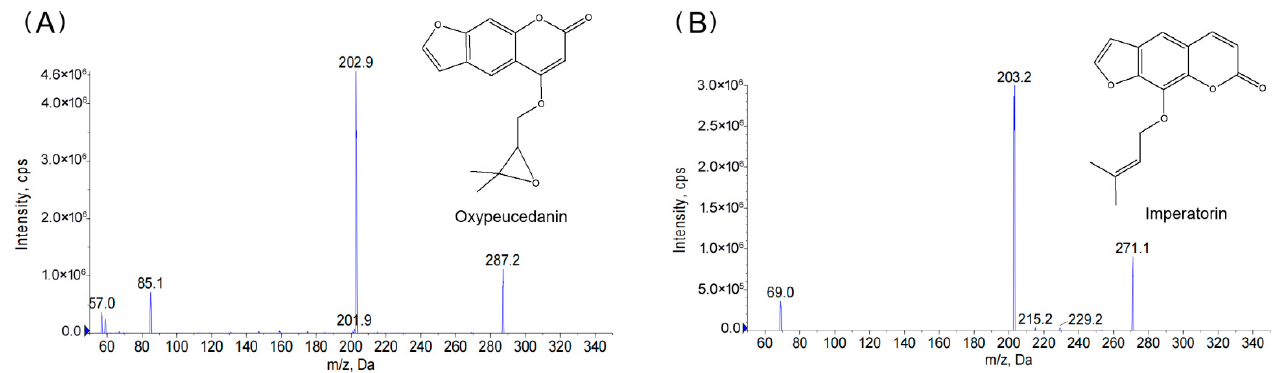
Figure 1. The chemical structure and the product ion spectra of oxypeucedanin ( A ) and the internal standard imperatorin ( B ) with monitoring at m / z 287 → 203 for oxypeucedanin and 271 → 203 for imperatorin (IS).